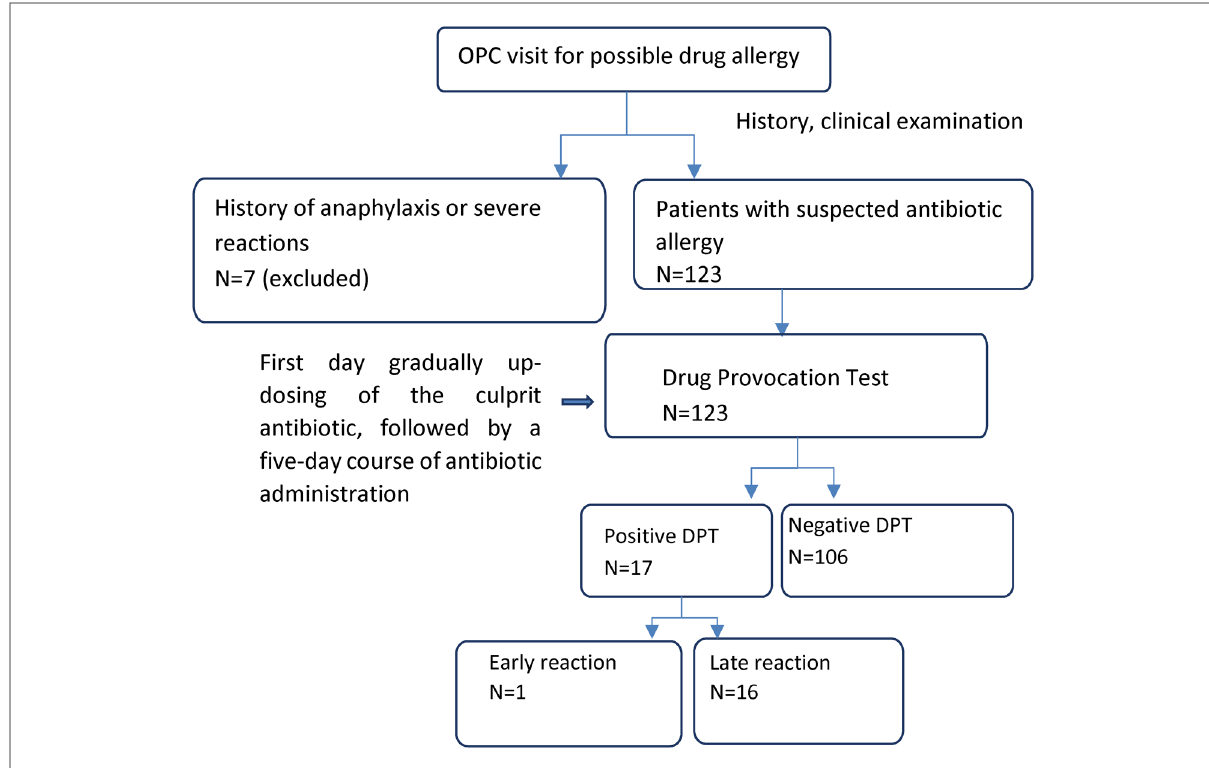
FIGURE 1 Protocol illustrating the procedure of the drug provocation